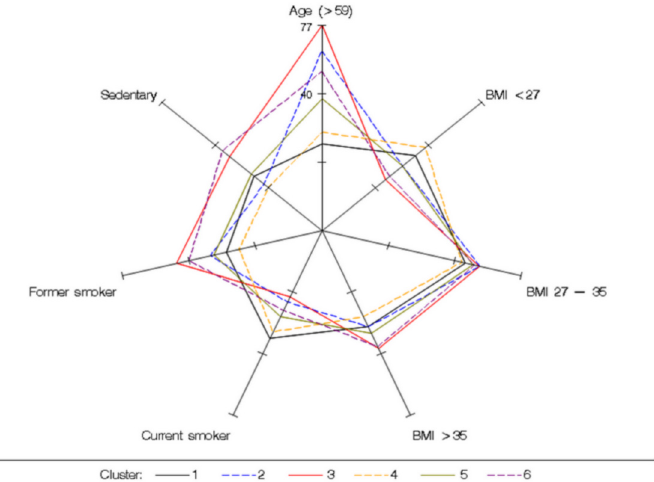
Fig 2. Conditional probabilities of BMI, age and risk factors to highlight the major differences among clusters. Cluster 1: the young symptomatic. Cluster 2: the old obese. Cluster 3: the multi-disease (MD) old obese. Cluster 4: the young snorers. Cluster 5: the drowsy obese. Cluster 6: the MD obese symptomatic